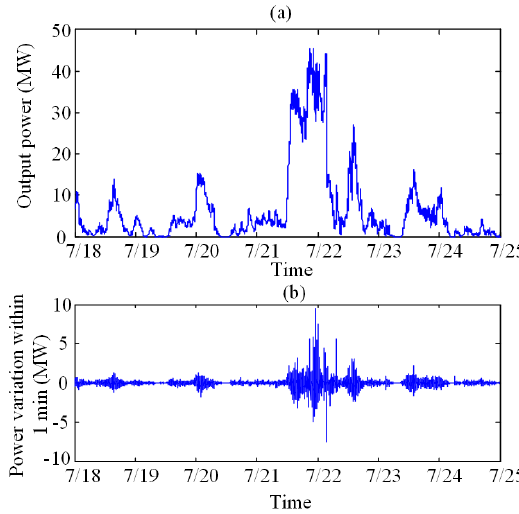
Figure 20. Wind farm output power ( a ) and output power variation within 1 min ( b ).